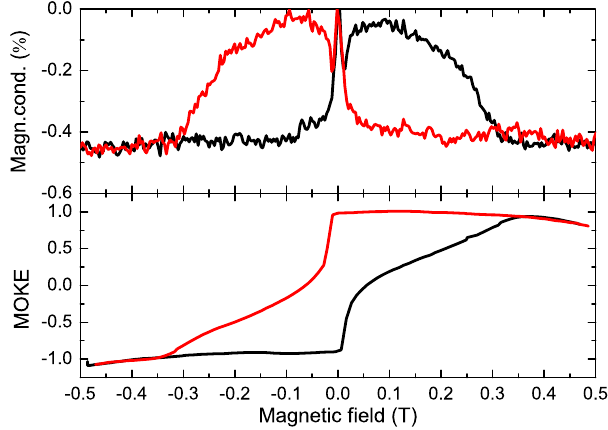
FIG. 4. Magnetoconductivity of a PEDOT-only semi–spin valve. The top panel shows the magnetoconductivity in semi–- spin-valve control devices without the Alq 3 layer. The device structure consists of a ferromagnetic bottom electrode, the 40-nm PEDOT spacer layer, Ca, and Al. The bottom panel shows the magneto-optic Kerr-effect (MOKE) measurements of the magnetic electrode. The experiments were performed in a perpendicular applied magnetic field.